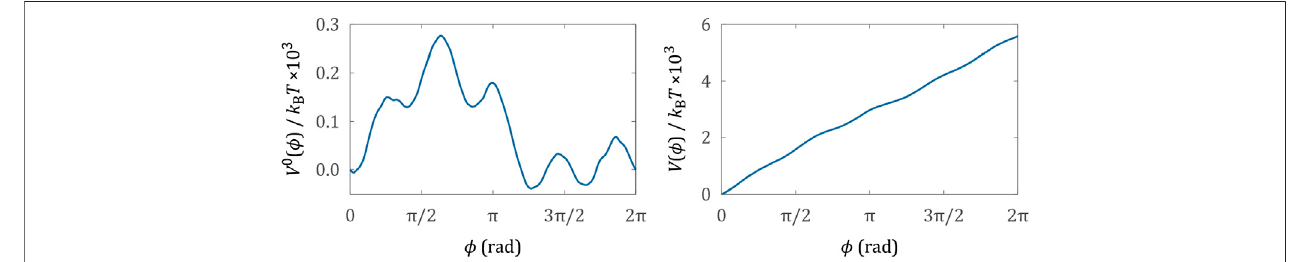
FIGURE 3 | Conservative (left hand side) and total potentials (right hand side).